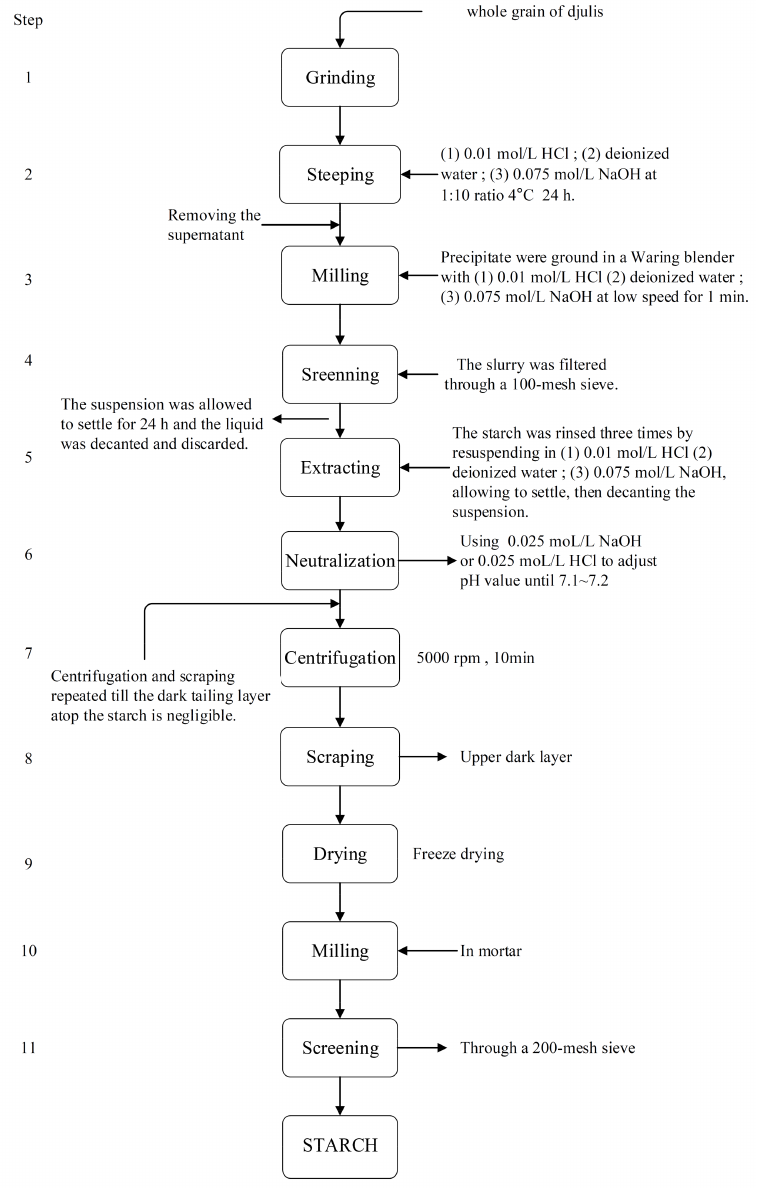
Figure 5. (1) Hydrochloric acid (HP); (2) deionized water (WP); and (3) alkali (NP) isolation procedures for djulis